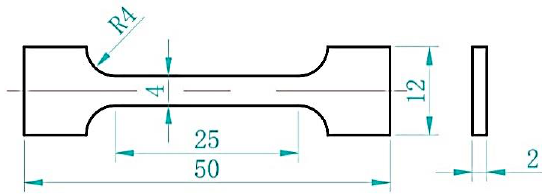
Figure 3. Sample for tensile strength testing (Unit: mm).